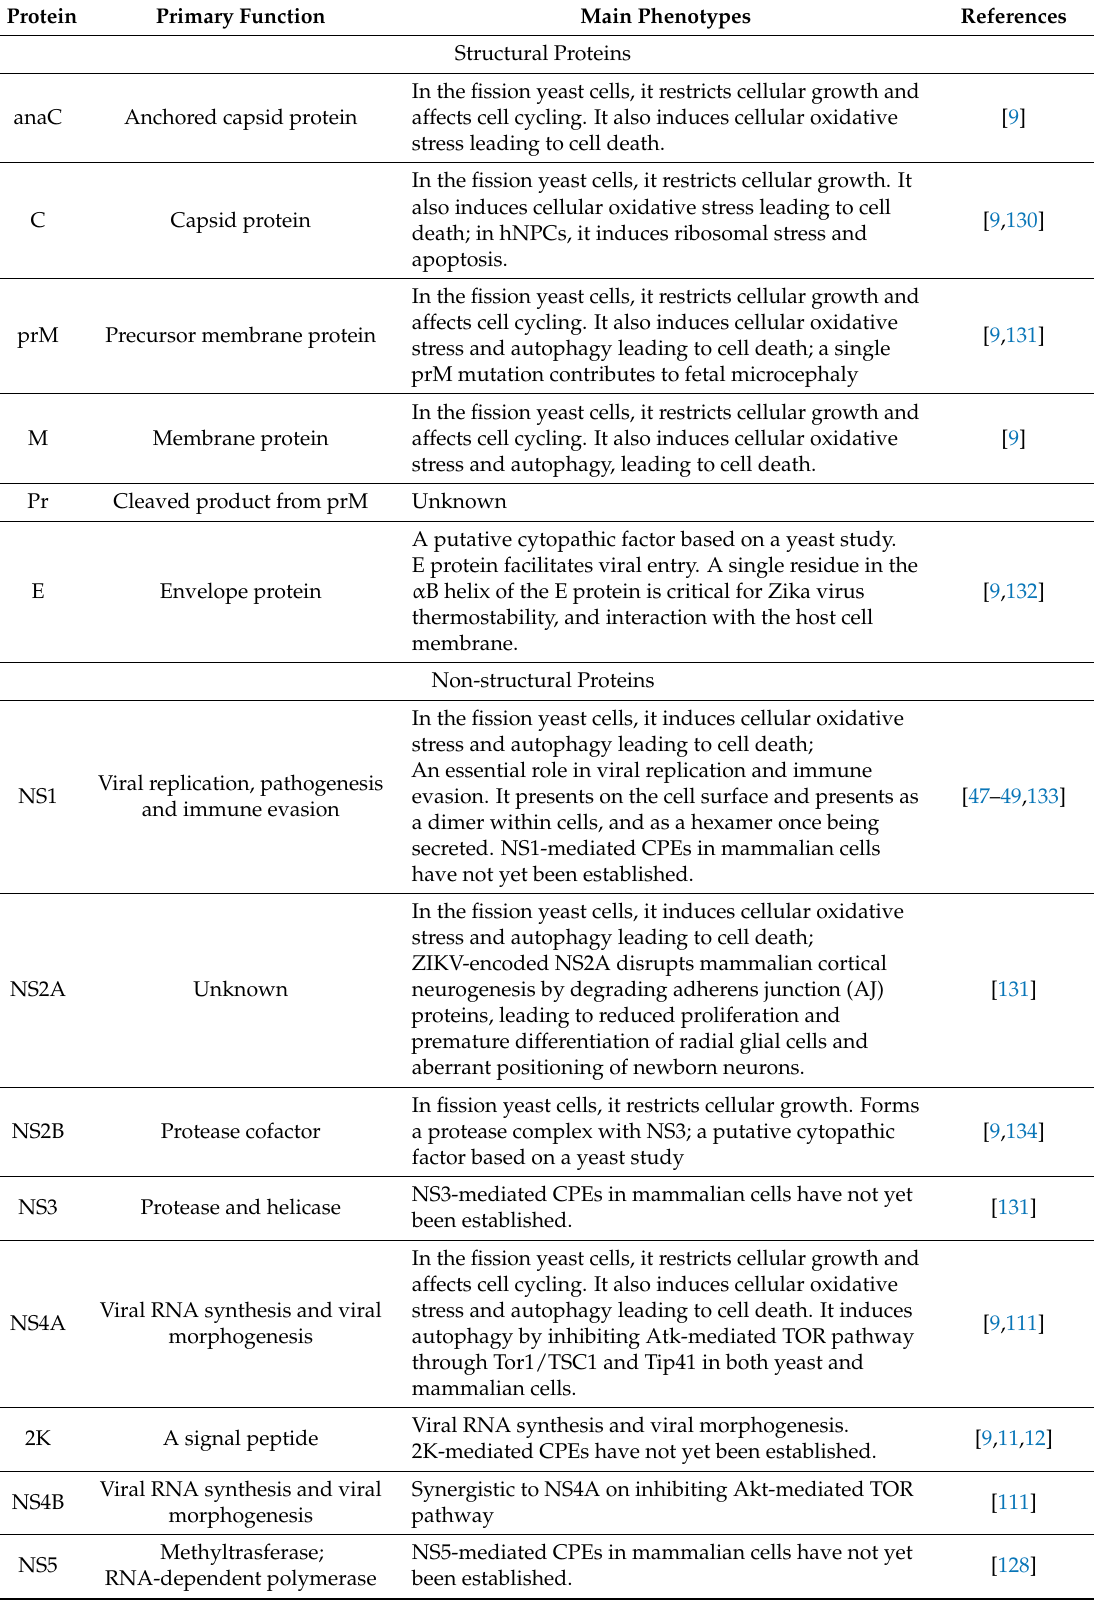
Table 4. ZIKV proteins and associated cytopathic